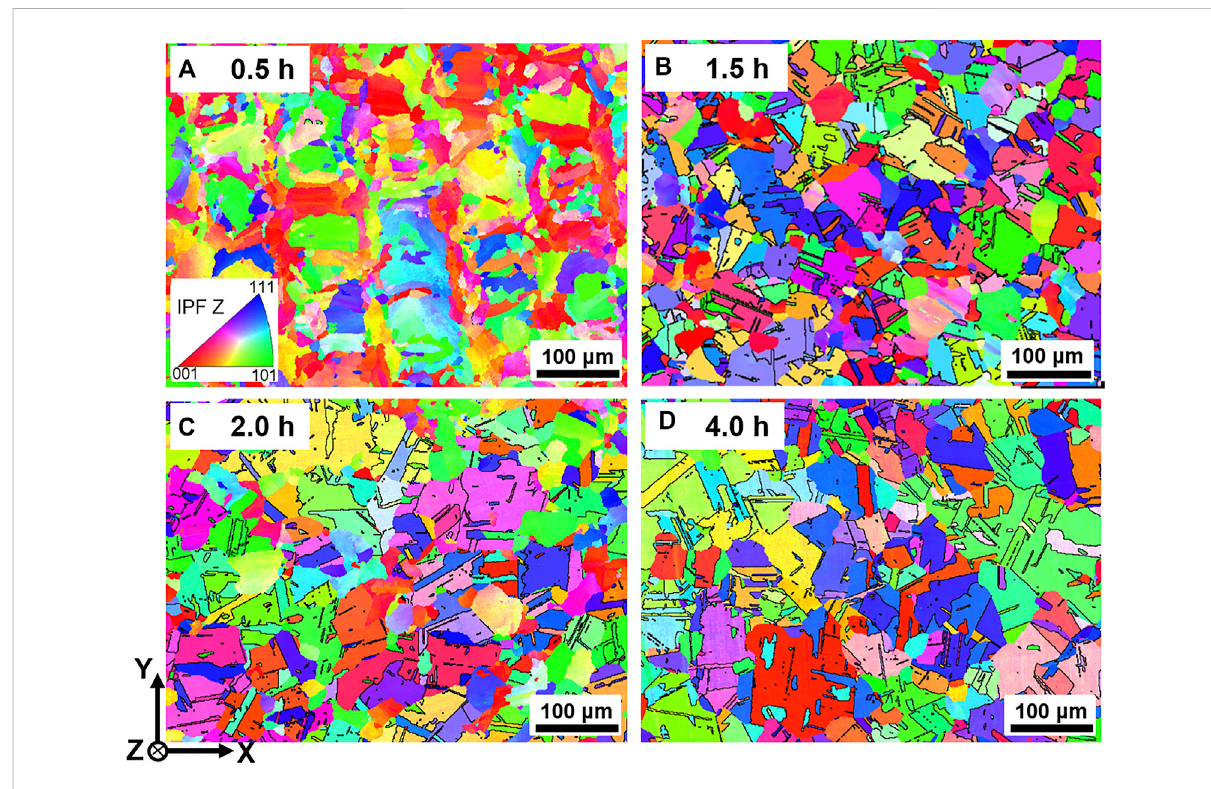
FIGURE 7 EBSD IPF images of Inconel 718 samples fabricated via the L-PBF at homogenization temperature of 1,080 ° C for different times (A) 0.5 h, (B) 1.5 h, (C) 2.0 h, and (D) 4.0 h.